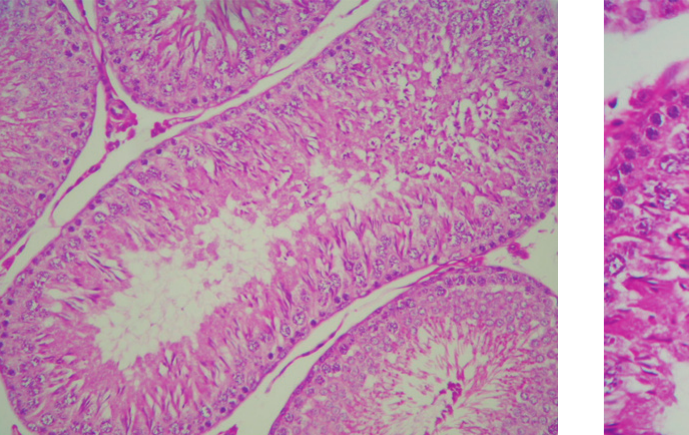
Figure 1a - Spermatogenesis with a Johnsen score of 9.8 in the control group. A seminiferous tubule with normal sper- matogenesis is seen.